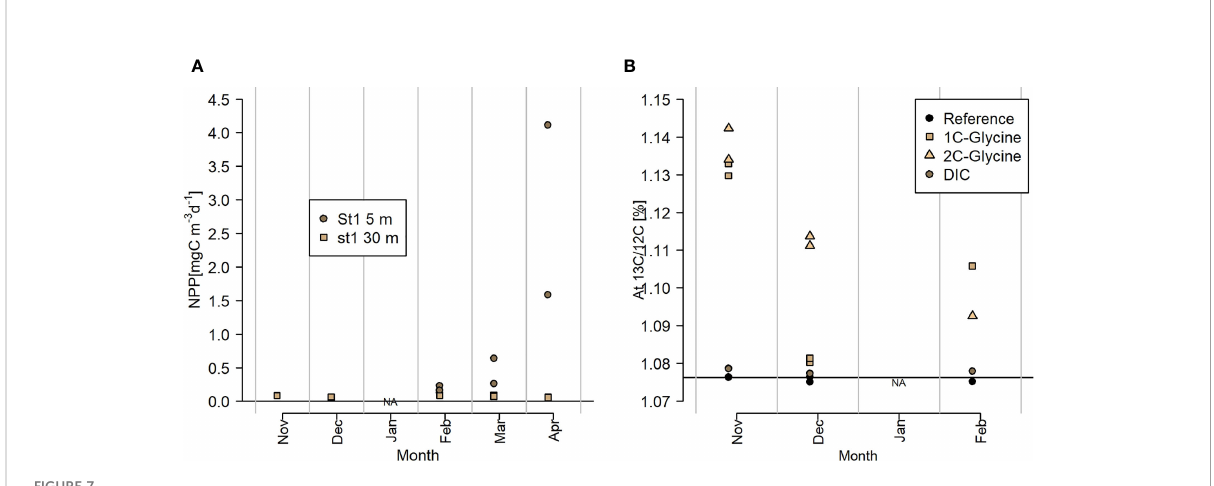
FIGURE 7 (A) Net primary productivity estimates based on isotope enrichment experiments after 24 h in situ incubations with 13 C-DIC (30m Nov-Feb) and 14 C-DIC (rest), (B) Atomic 13C/12C ratio (%) as proxy for uptake of 13 C (Nov to Feb only).